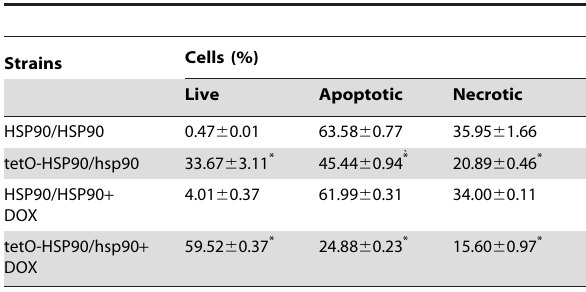
Table 3. The percentage of cells in C. albicans after AMB treatment with or without DOX 3 .